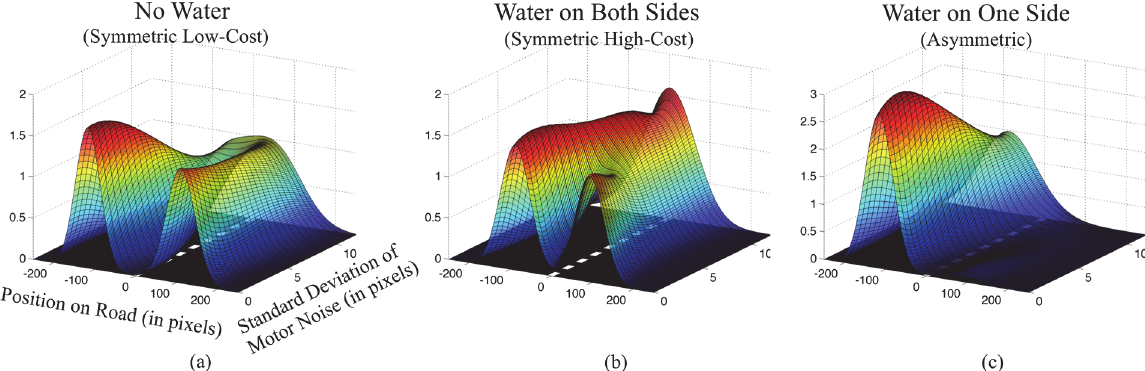
Fig 4. Continuous position probability distribution as a function of uncertainty. Variables of bimodal Gaussian fits ( μ 1, μ 2, σ 1, σ 2, and p) from Fig 3 were interpolated (using cubic spline interpolation) across noise levels. This demonstrates an estimate of the probability of where on the road a subject will be at any given instant as a function of motor